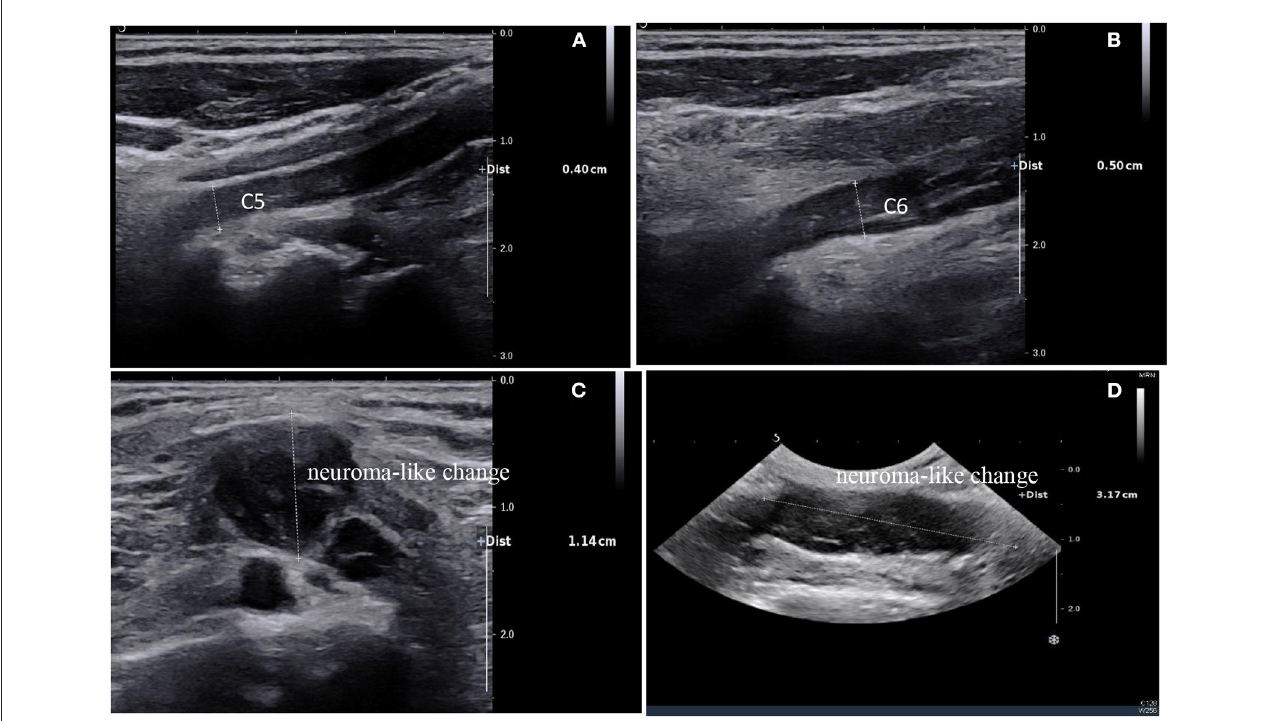
FIGURE2 Ultrasound of the brachial plexus showed a high degree of thickening of the C5 and C6 nerve roots, ∼ 0.4cm and 0.5cm respectively (A, B) ; diffuse edema of the superior, middle, and inferior trunks were seen in the interosseous sulcus; Brachial plexus neuroma-like change of brachial plexus in the